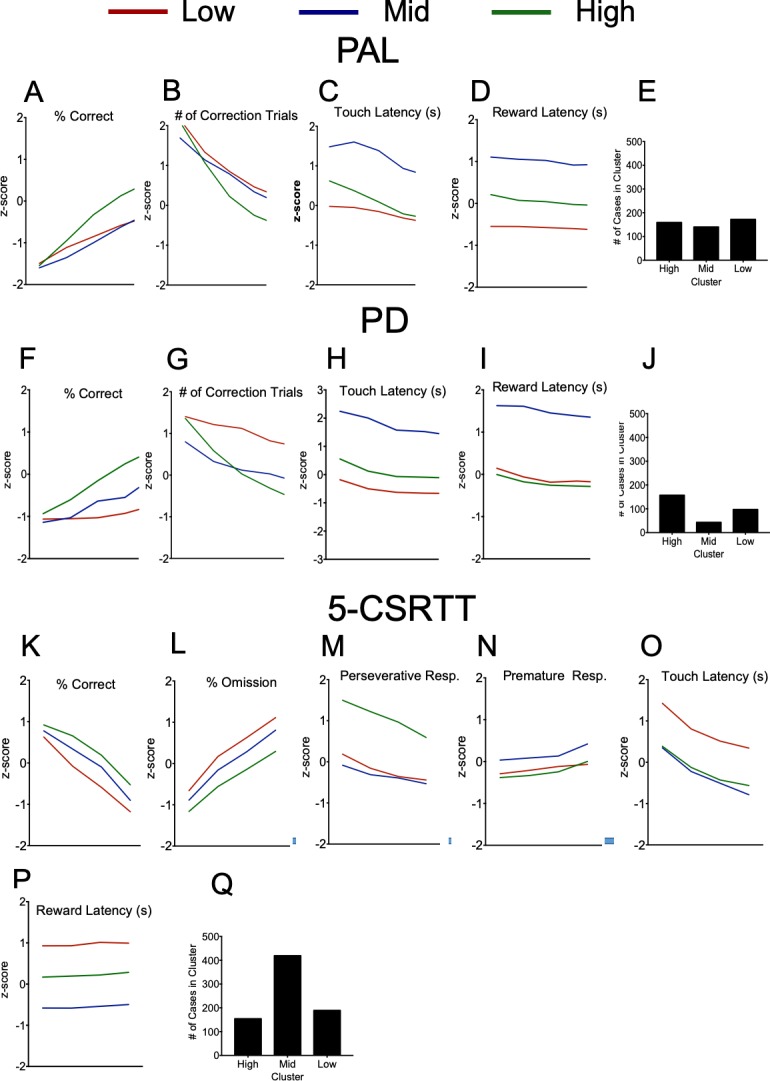
Results of longitudinal clustering analysis of PAL, PD and 5-CSRTT data. z-scores for parameters assessed during the 5-CSRTT, sorted by cluster.For PAL – (A) Accuracy across blocks by cluster. (B) Number of correction trials across blocks by cluster. (C) Correct Touch latency across blocks by cluster (D) Reward latency across blocks by cluster. (E) Number of mice belonging to each cluster across strain, age, sex and genotype. The high performing cluster is characterised by low errors and high accuracy. The middle performing cluster is characterised by middle accuracy and errors, as well slow response times. The low performing cluster is characterized by low accuracy and high errors. For PD - (F) Response accuracy across trials by cluster. (G). Errors committed across trials by cluster. (H) Response latency across trials by cluster. (I) Reward collection latency across trials by cluster. The high performing cluster is characterised by low errors and high accuracy. The middle performing cluster is characterised by middle accuracy and errors, and slow response times. The low performing cluster is characterised by low accuracy and high errors. (J) Number of mice belonging to each cluster across strain, age, sex and genotype. For 5-CSRTT - (K) Response accuracy across trials as stimulus duration is reduced. (L) Omission errors committed as stimulus duration is reduced. (M) Perseverative responses as stimulus duration is reduced. (N) Premature responses as stimulus duration is reduced. (O) Correct response latency as stimulus duration is reduced. (P) Reward collection latency as stimulus duration is reduced. The high performing cluster is characterised by low omissions, high accuracy, but high number of perseverative responses. The middle performing cluster is characterised by middle accuracy and omission, and increased number of premature responses. The low performing cluster is characterised by low accuracy, high omission, and slow response times (Correct touch latency and reward collection latency) (Q) Number of mice belonging to each cluster across strain, age, sex and genotype.